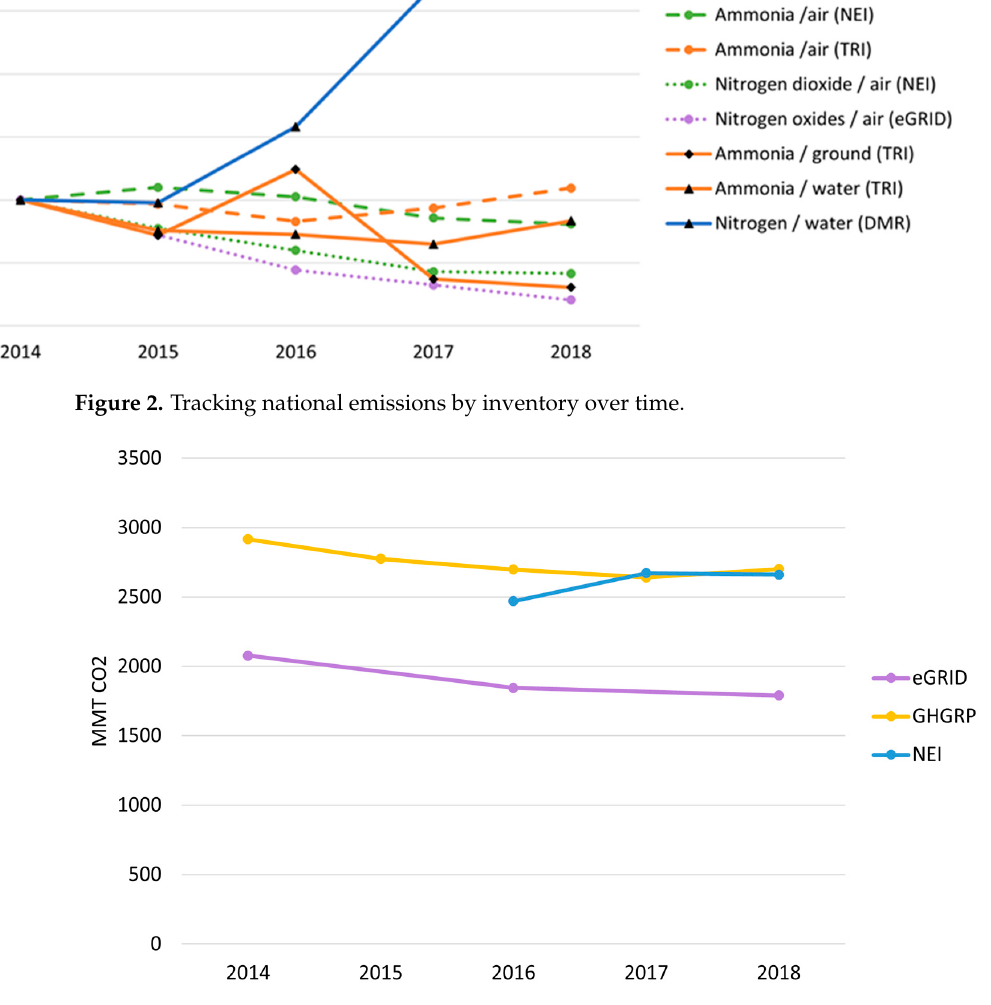
Figure 3. National carbon dioxide emissions by inventory over time.